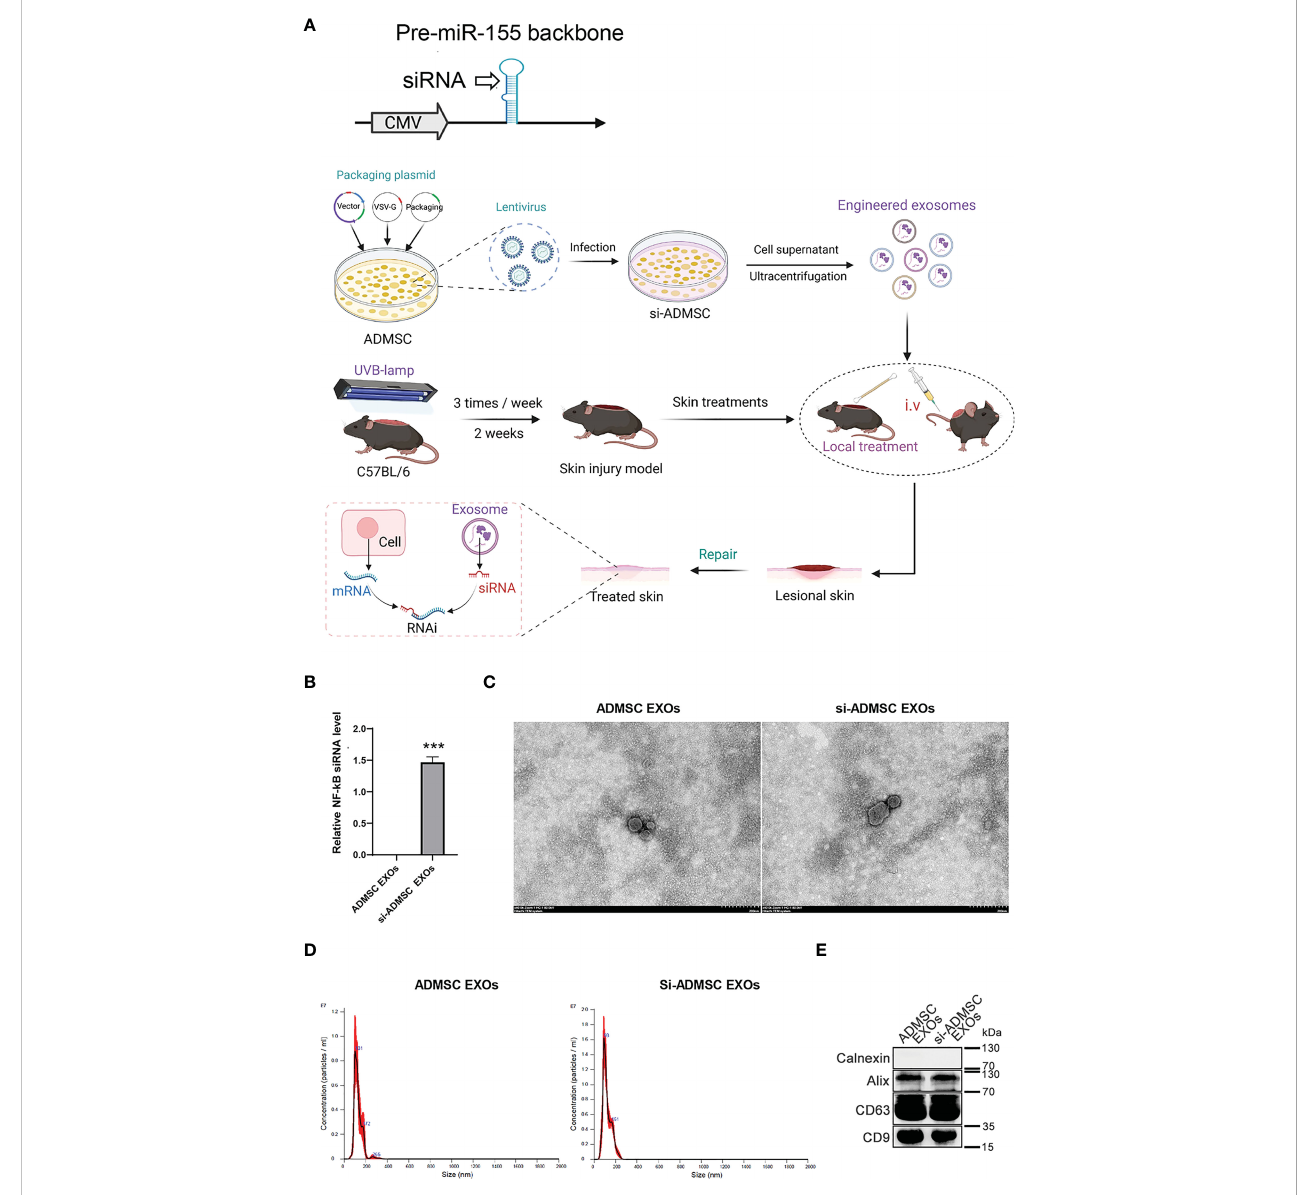
FIGURE 2 Biosynthesis of engineered si-ADMSC-EXOs. (A) Schematic of the experimental design. Genetic circuit were constructed consisting of two functional modules: the promoter module drives the transcription of siRNA, which leads to the package of saturated cytoplasmic siRNA into exosomes, while the siRNA expression cassette module maximises the expression of the siRNA guide strand and minimises the expression of undesired passenger strand. The cytomegalovirus (CMV) promoter was selected as the promoter module, and the pre-miR-155 backbone was selected as the optimal siRNA expression cassette to produce siRNA. We then constructed lentivirus containing these siRNA-expressed genetic circuit and infected with ADMSC cells. siRNA expressed-ADMSC cells were selected (si-ADMSCs) and the secreted exosomes were obtained through ultracentrifugation. The skin lesions were treated through swearing the si-ADMSC exosomes. (B) Quantitative PCR analysis the siRNA level of NF- k B in si-ADMSC exosomes and normal ADMSC exosomes. (C-E) Transmission electron microscopy (C) , nanoparticle size tracking (D) , western blot (E) assay of exosomes extracted from si-ADMSC and ADMSC cell culture medium. *** p